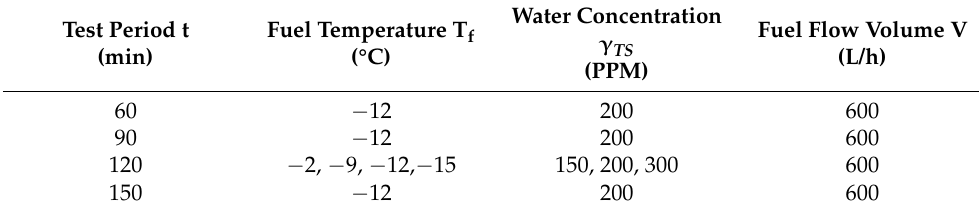
Table 1. Experimental Conditions on ice accretion of aviation jet fuel